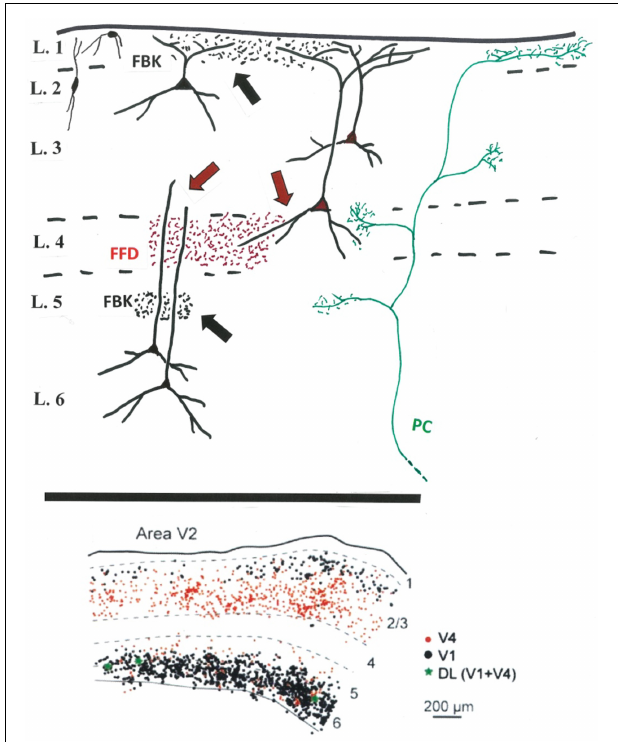
FIGURE 1 | Above: Schematic sketch (V2) of FFD (in red) and FBK terminations (in black) in relation to potential postsynaptic dendrites (black) of FFD (red soma) and FBK (black soma) projecting neurons. FFD teminations in layer 4 (red arrows) potentially contact small pyramidal cells or interneurons in layer 4, basal dendrites of FFD neurons, and distal dendrites of FBK neurons. FBK or other terminations in the infragranular layers (black arrow) might access more proximal apical dendrites of infragranular neurons. Included for reference, a typical, multilaminar pulvino-cortical (PC) axon (in green) (And see Federer et al., 2021: terminations in V1 after viral infection of V2). Not shown: layer 5 neurons, inhibitory neurons (except for the representative neurons at upper left), intra- and interlaminar intrinsic connections, and the additional afferent inputs to layer 1 or other layers. Below: Predominant segregation of FFD (in red) and FBK (in black) projecting neurons in V2, as demonstrated by double retrograde injections in V1 and V4, with a small number (in green) of double labeled (DL) neurons (modified from Figure 10 in Markov et al.,